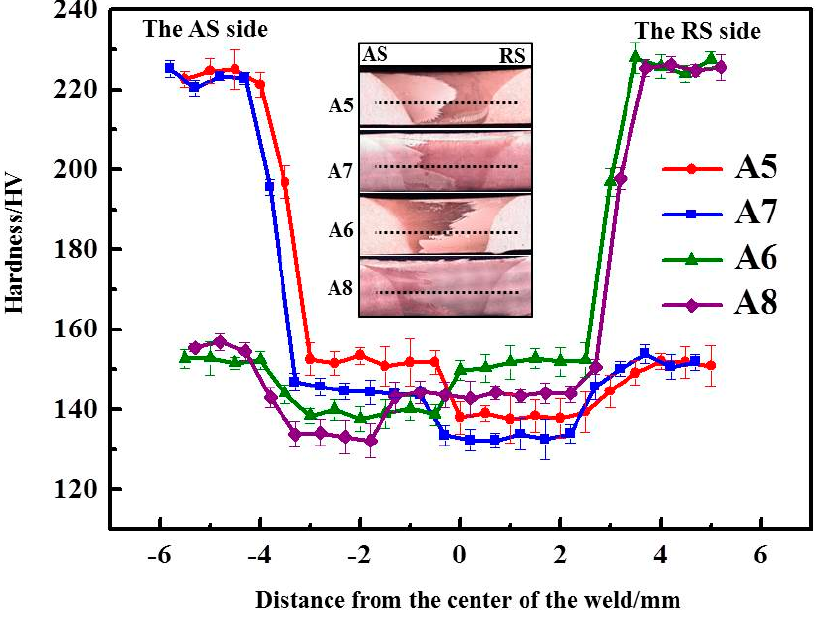
Figure 9. The microhardness along the centreline of dissimilar CuCrZr/CuNiCrSi joints.